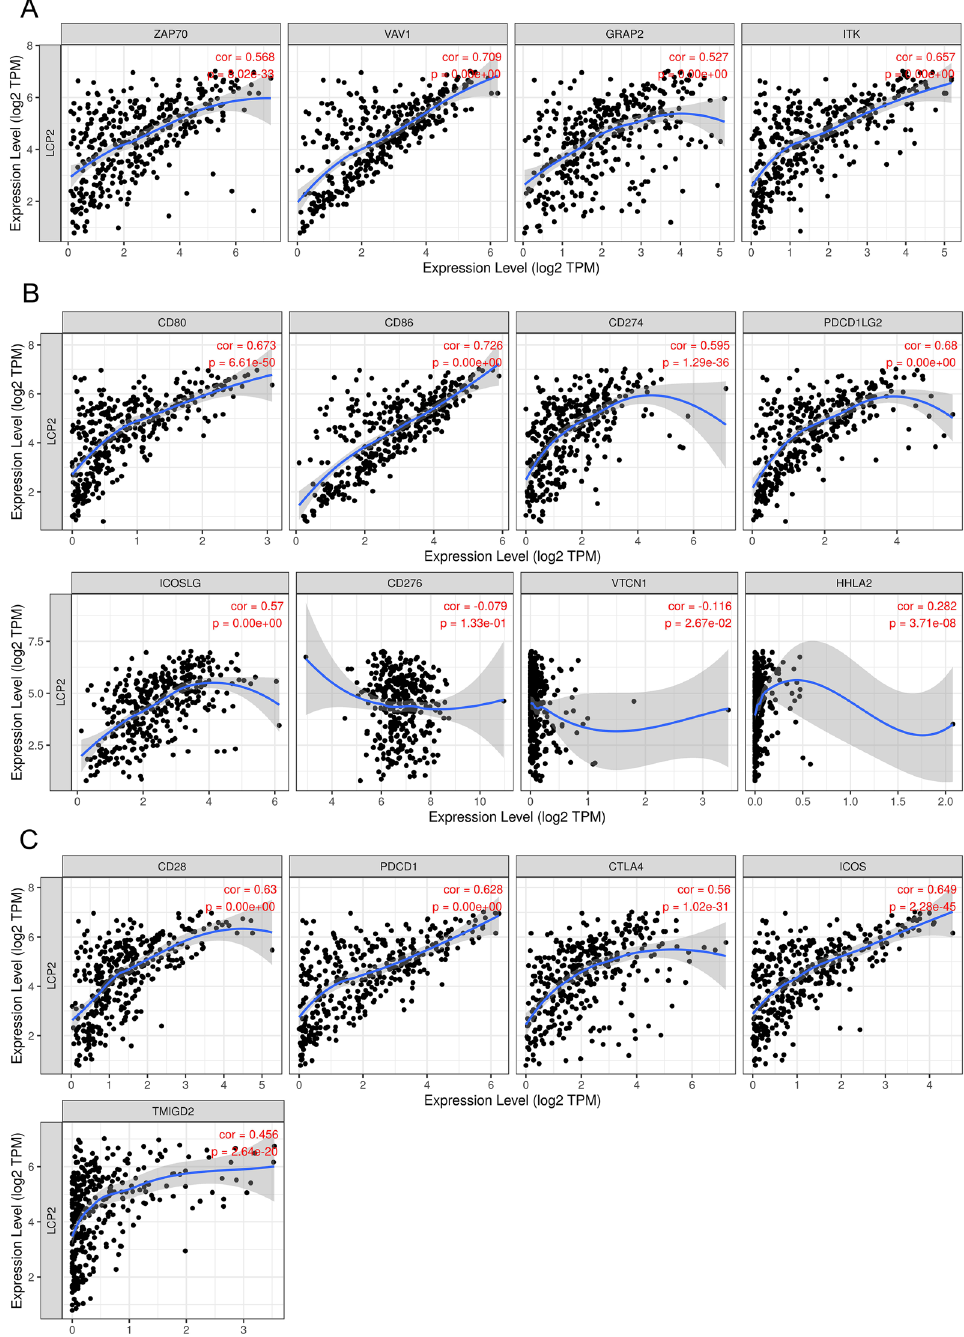
Figure 6. The correlation between LCP2 and signal molecules of TCR/CD28-B7 checkpoint families. ( A ) LCP2 expression level was correlated with ZAP70 , VAV1 , GRAP2 , ITK in SKCM-Metastasis. ( B ) LCP2 expression level was correlated with CD80, CD86, CD274, PDCD1LG2, ICOSLG, CD276, VTCN1, HHLA2 in the SKCM- Metastasis cohort. ( C ) LCP2 expression level was correlated with CD28, CTLA4, PDCD1, ICOS and TMIGD2 in the SKCM-Metastasis cohort. SKCM skin cutaneous